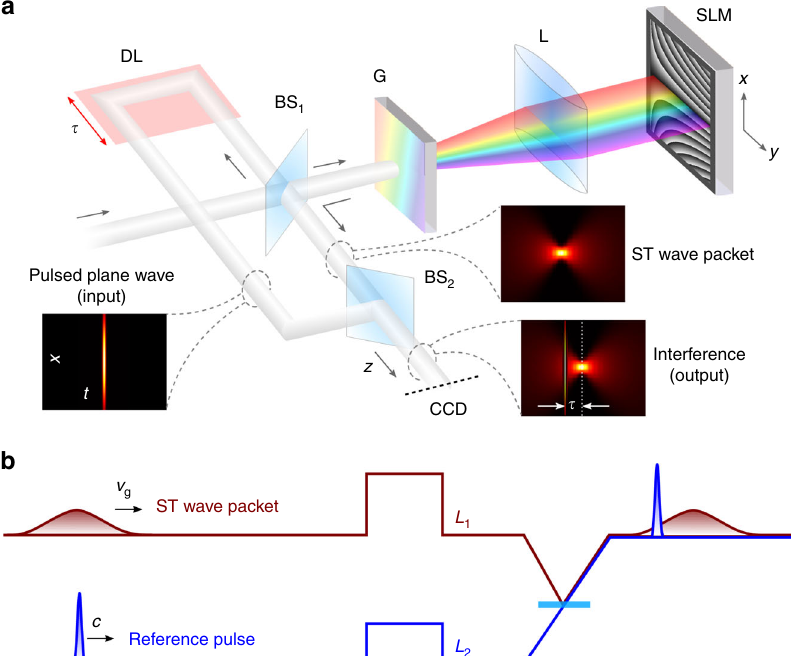
Fig. 2 Synthesizing space-time (ST) wave packets and measuring their group velocity. a A pulsed plane wave is split into two paths: in one path the ST wave packet is synthesized using a two-dimensional pulse shaper formed of a diffraction grating (G), cylindrical lens (L), and spatial light modulator (SLM), while the other path is the reference. BS beam splitter, CCD charge-coupled device, DL delay line. The insets provide the spatio-temporal pro fi le of a ST wave packet with a Gaussian spectrum, the reference pulsed plane wave, and their interference. See Methods and Supplementary Fig. 1 for details. b The reference and the ST wave packets are superposed, and the shorter reference pulse probes a fraction of the longer ST wave packet. Maximal interference visibility is observed when the selected delays L 1 and L 2 cause their peaks to coincide; see Methods and Supplementary Figs